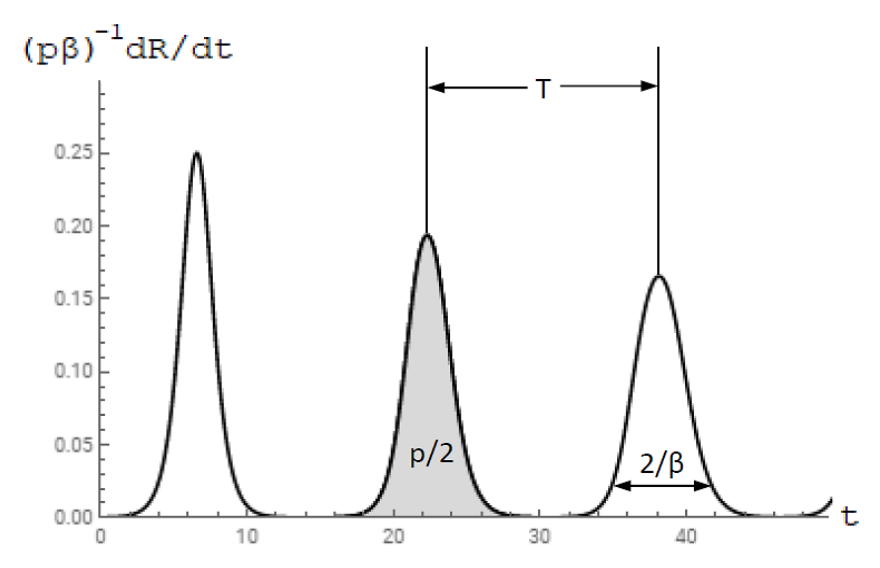
Figure 9. The meaning of the 𝑻,𝒑 and 𝜷 parameters of the two-component model The waves are smoothed out if their width (2/𝛽) becomes of the order of the distance between them (𝑇) , i.e., at 𝛽𝑇 < 2 . This tendency is visible in Figure 7. The same effect on the incidence waves also causes the lifetime form- factor ∆ shown above in Figure